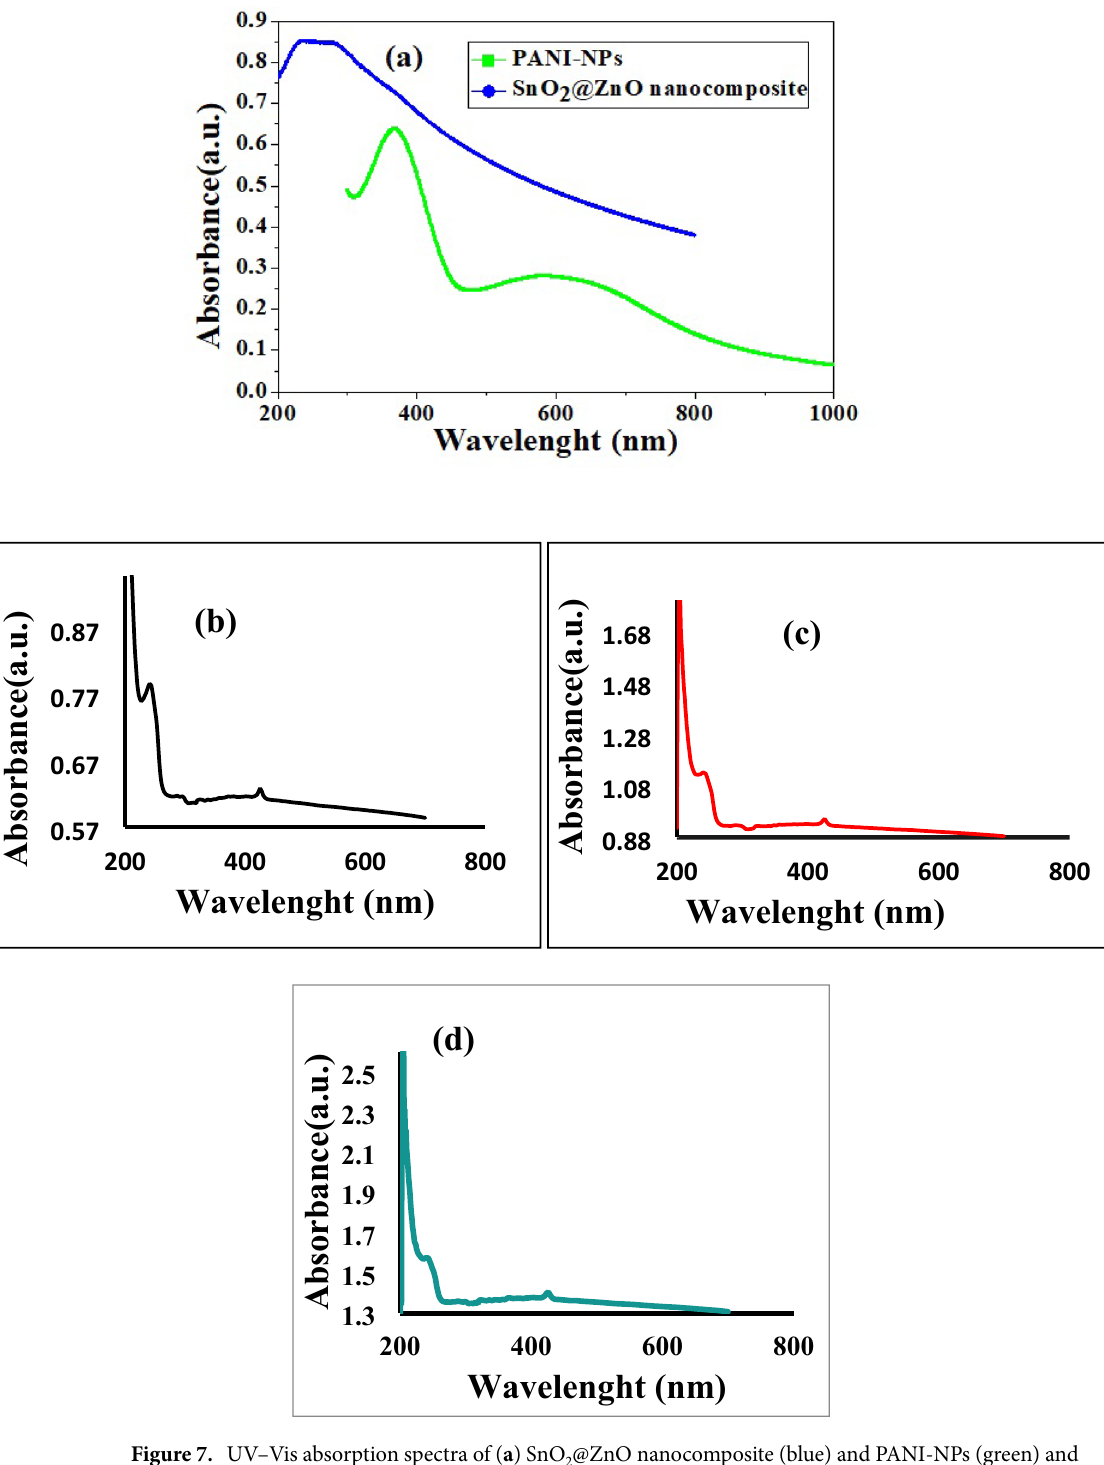
Figure 7. UV–Vis absorption spectra of ( a ) SnO 2 @ZnO nanocomposite (blue) and PANI-NPs (green) and ( b – d ) different volume ratios of SnO 2 @ZnO.PANI (2%, 4%, and 6%)